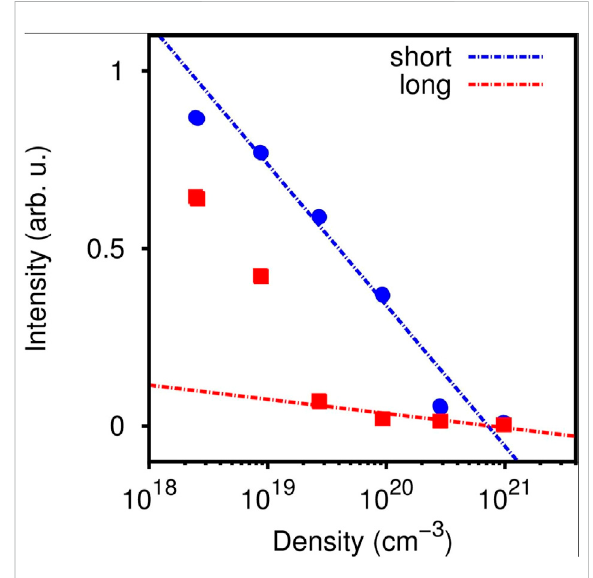
FIGURE 1 Simulated signal of harmonic radiation as a function of the density of argon ions (single-ionized). The data have been collectedfromStrelkovetal.[36].Onlytheexperimentallyrelevant middle group contributions are shown. The signal of the long trajectory (red squares) shows a decrease in the low-density regime,contrarily to theshort trajectory (blue dots)which drops at a signi fi cantly higher density. Additionally, a linear approximation to the high-density regime is depicted (dashed